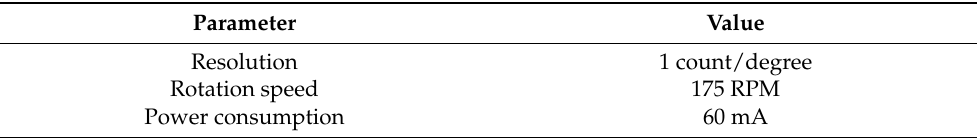
Table 4. General specification parameters for the inertial